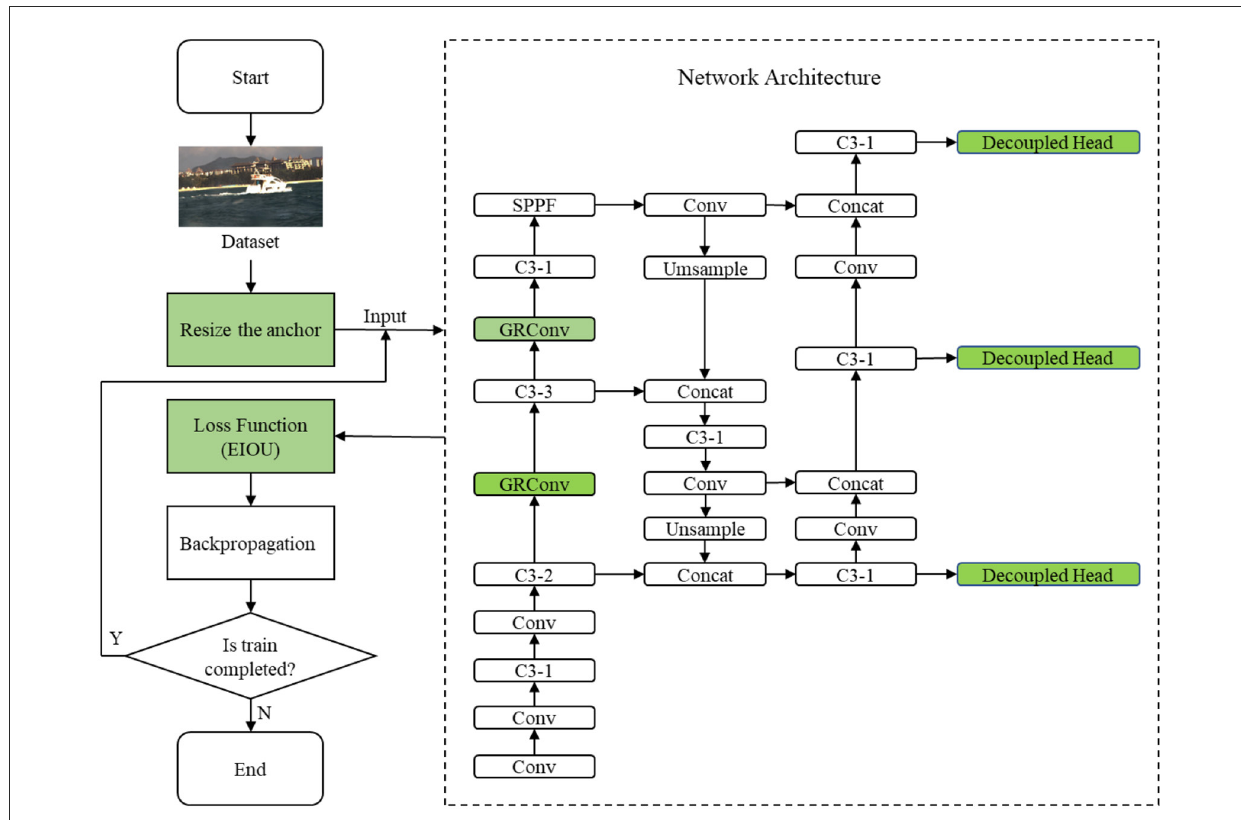
FIGURE1 Workflow diagram of the proposed network.